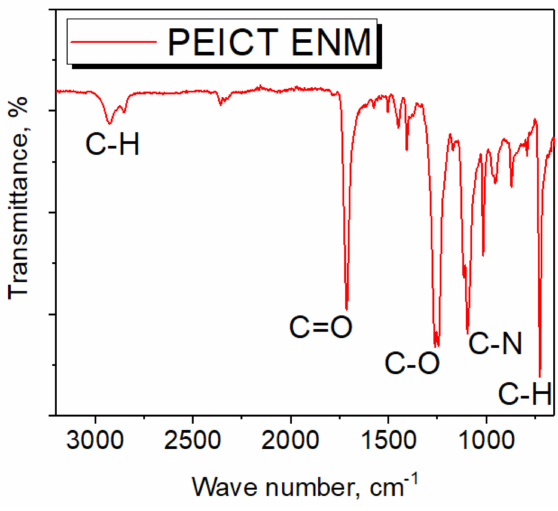
Figure 3. FTIR spectrum of PEICT